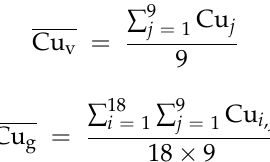
(cid:3364)(cid:3364)(cid:3364)(cid:3364)(cid:3364)(cid:3364) , are calculated, each from t,r , (cid:3364)(cid:3364)(cid:3364)(cid:3364)(cid:3364)(cid:3364) is calculated, as the g